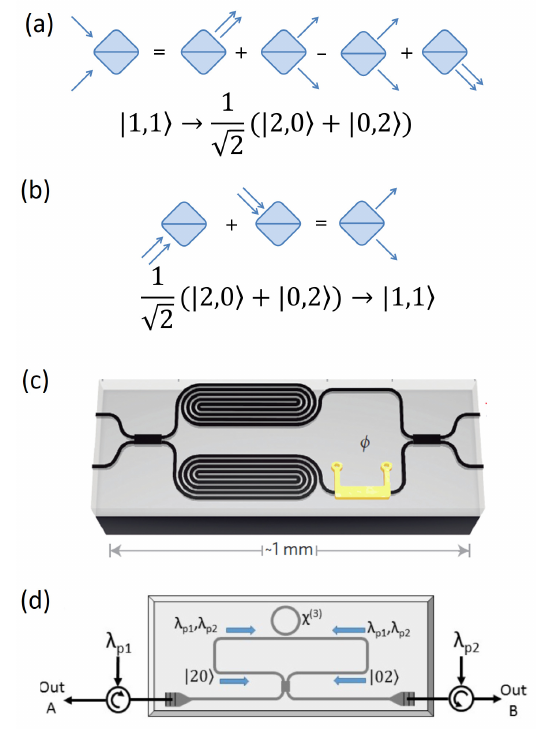
Fig. 7. Diagram for (a) HOM interference, and (b) time-reversed two photon HOM interference. In (a) two indistinguishable photons meet at a 50:50 beam spitter, and they always bunch and come out from one output ports. (b) is the reversed process of (a). Photon de- terministic splitting using (c) two separate nanowire photon sources and a micro-heater phase shifter [17], and (d) a single microring in a Sagnac loop